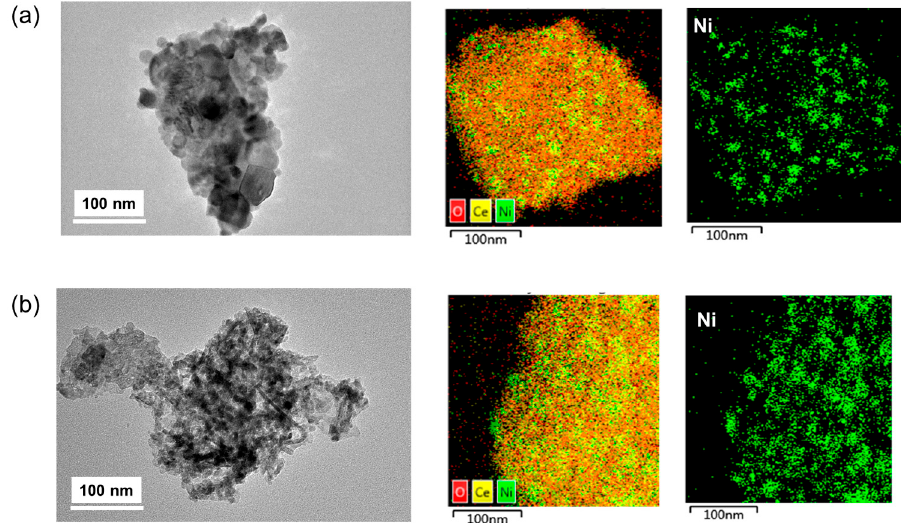
Figure 2. TEM and EDX images of ( a ) reduced Ni/CeO 2 -C catalyst and ( b ) reduced Ni/CeO 2 -M catalyst.